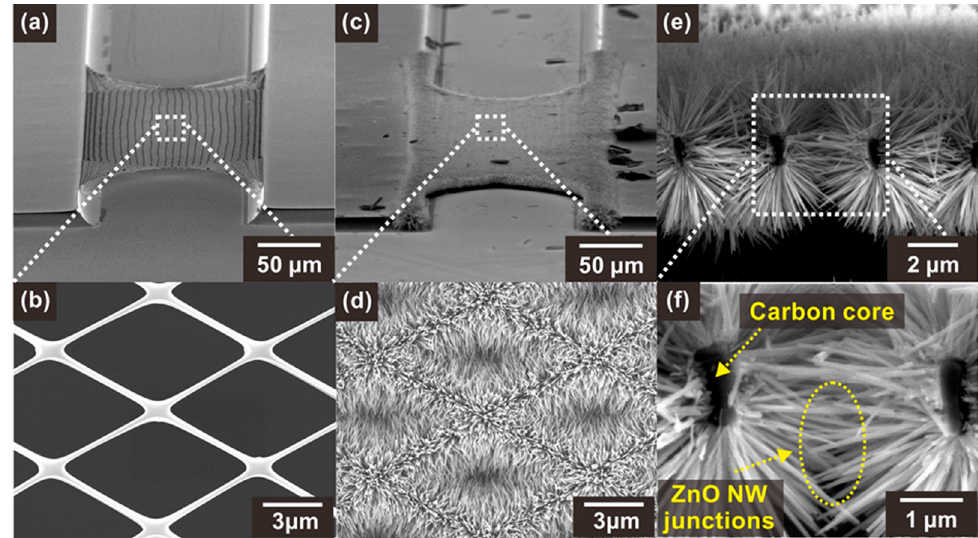
Figure 2. SEM images of ( a , b ) a bare suspended carbon nanomesh and ( c , d ) the same nanomesh functionalized with ZnO NWs. ( e , f ) SEM images of a section of carbon mesh showing a network of ZnO NW junctions.